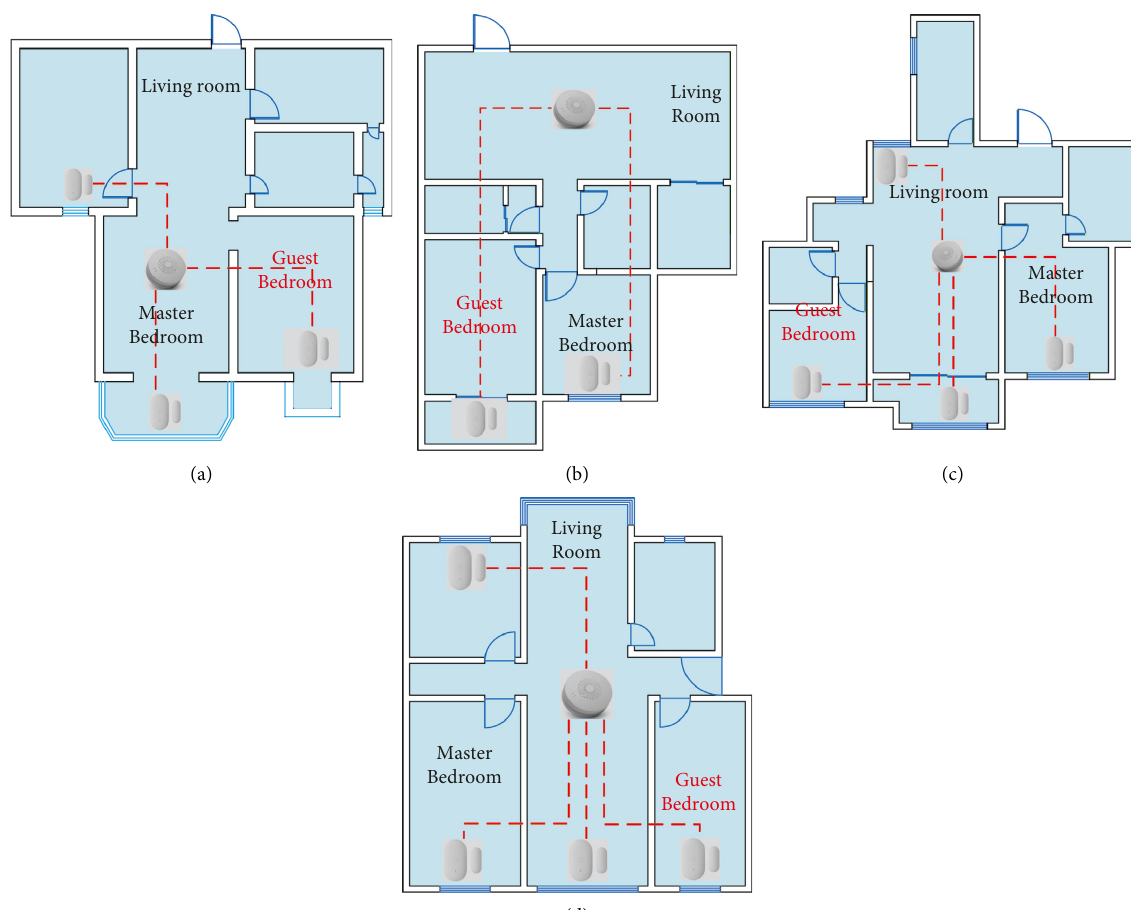
Figure 2: Floor plans for the selected four apartments: (a) residence #1, (b) residence #2, (c) residence #3, and (d) residence